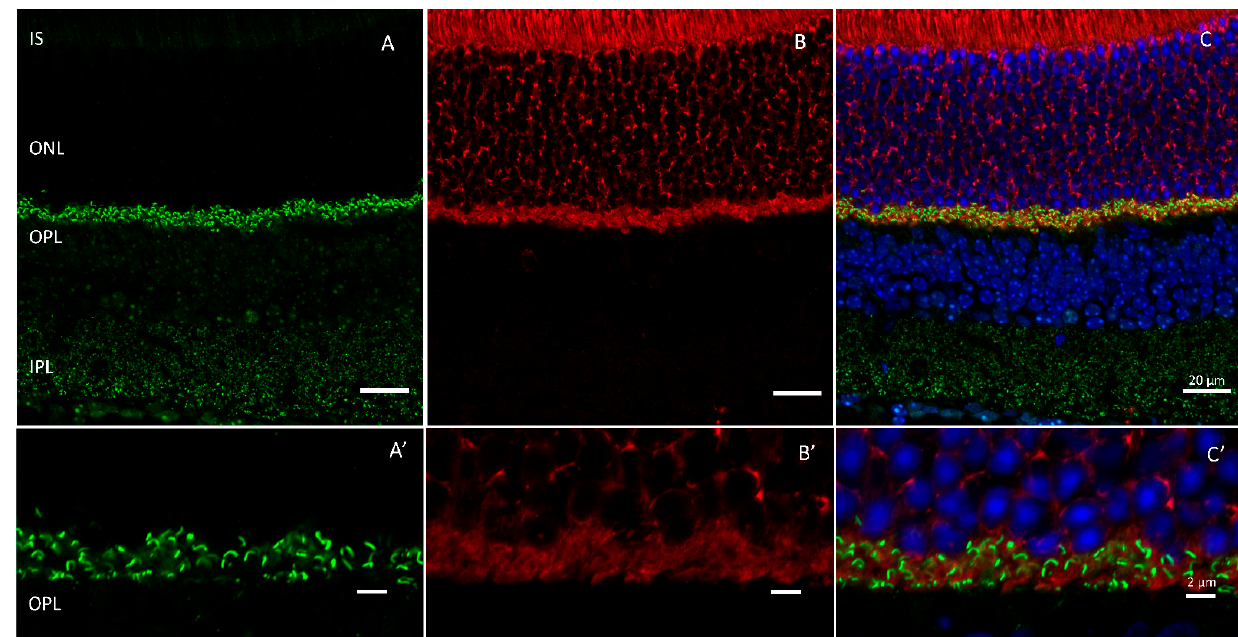
Figure 3. Tulp1 is expressed through retinal photoreceptors where it interacts with Ribeye in the outer plexiform layer. Wildtype mouse retinas labeled with antibodies against ( A ) Ribeye (green) and ( B ) Tulp1 (red). Outer plexiform layer shown in ( A’ – C’ ). Scale bar = 20 µm in ( A – C ) and 2 µm in ( A’ – C’ ).